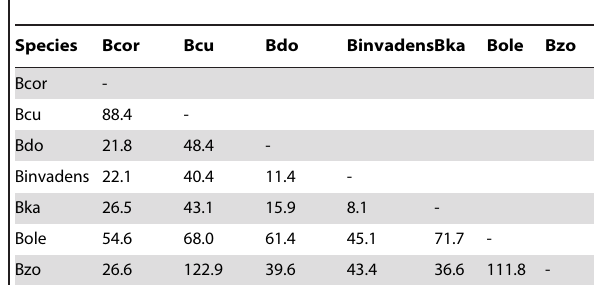
Figure 2. Projection of the wing and tibia data of Bactrocera invadens compared with other Bactrocera species on the first two canonical variates.